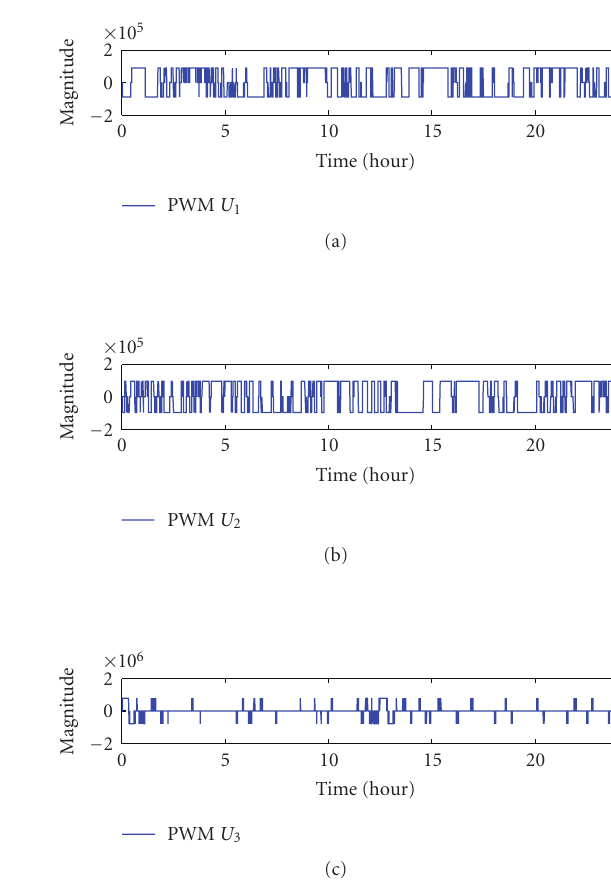
Figure 15: PWM control inputs of Scenario 1 with fault-tolerant